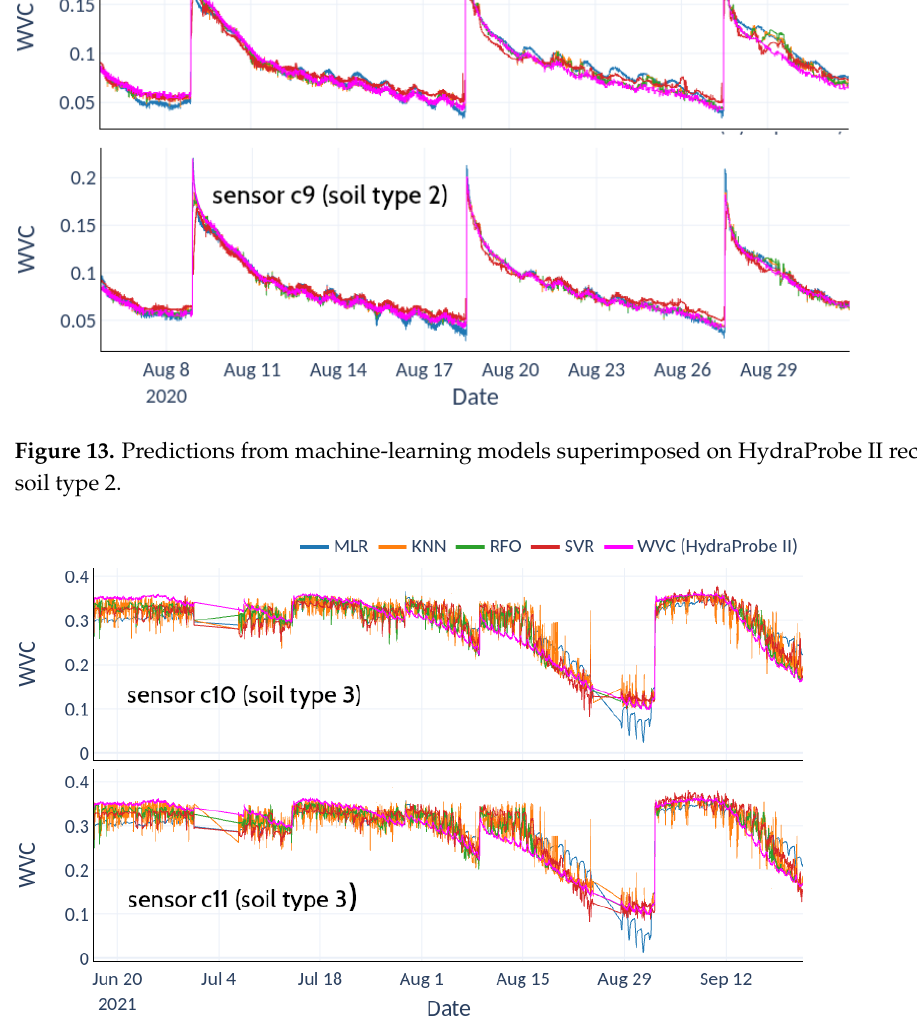
Figure 14. Predictions from machine-learning models superimposed on HydraProbe II records for soil type